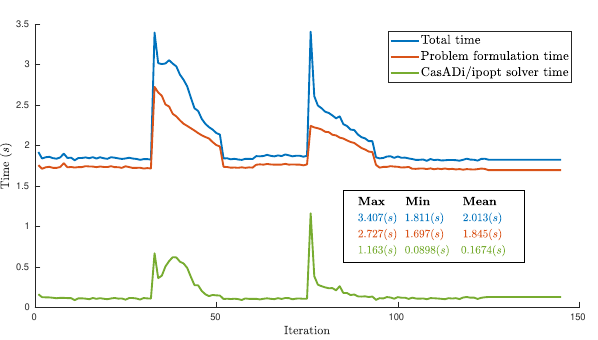
Figure 19: Runtime for the proposed algorithm for Simulation 3. The total time is split into the time for formulating the OCP, and the time the solver uses to find an optimal so- lution. The spikes clearly clearly indicate when TS 1 and TS 3 is included in N pri .